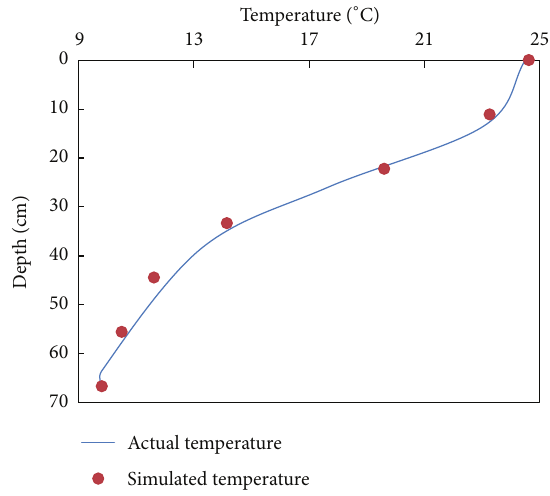
Figure 2: Temperature distribution in the